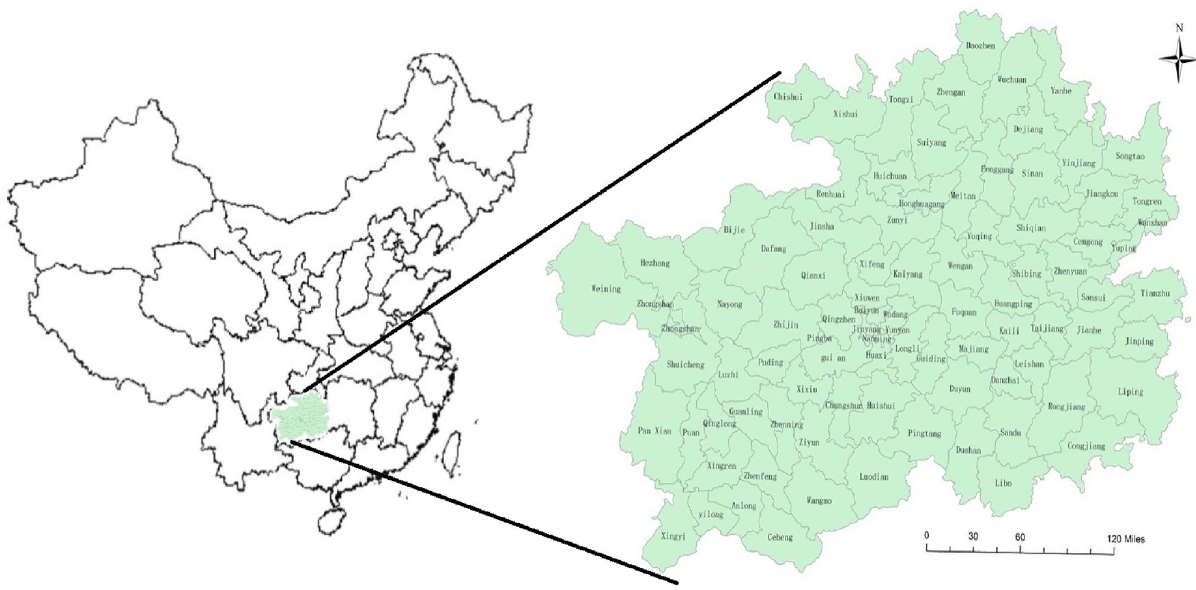
Figure 1. Location of Guizhou Province, China (ArcGis 10.2